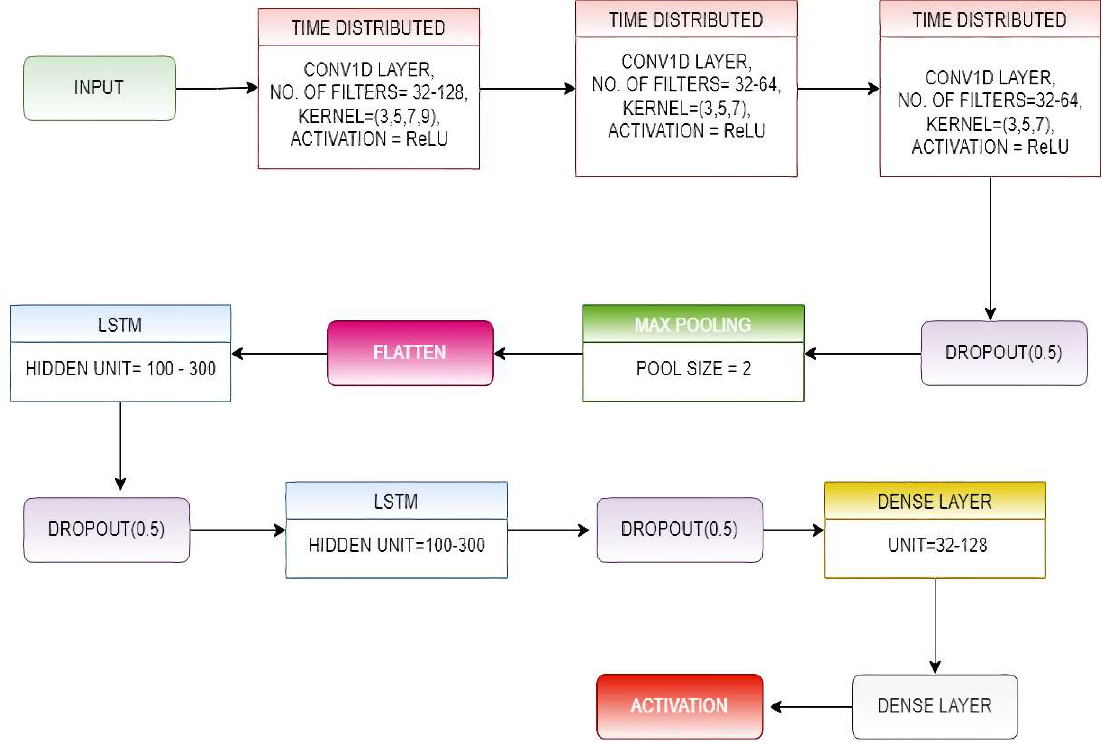
Figure 4. Schematic diagram of the ConvLSTM-Net model.